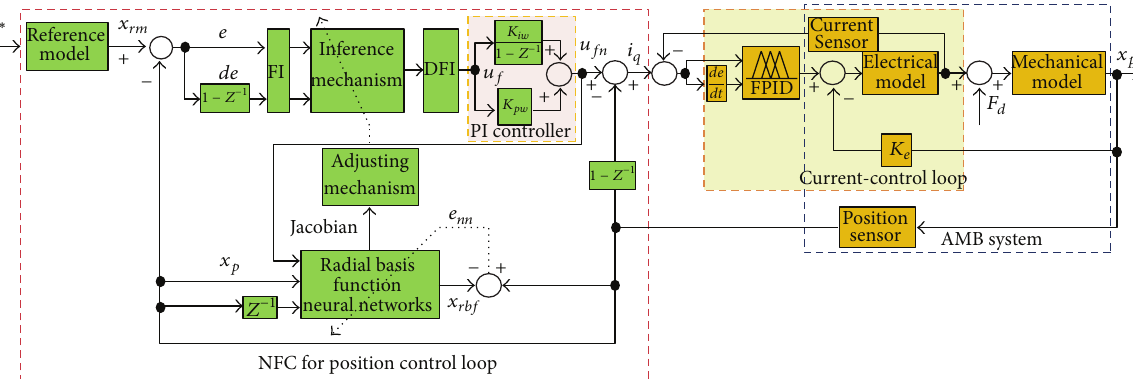
Figure 9: Block diagram neural fuzzy control for AMB system.